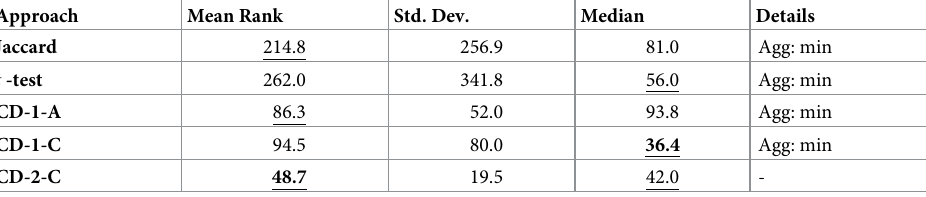
Table 2. Closed discovery: Mean and median ranks on the cancer discovery cases.